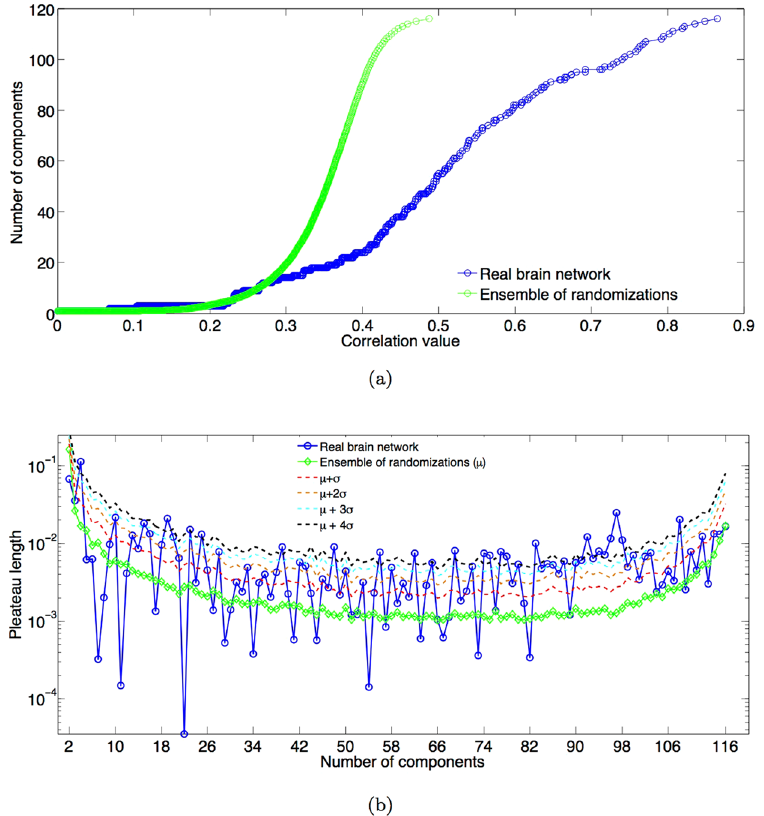
Figure 2. Percolation analysis. ( a ) Distribution of the number of network components versus the threshold applied to the correlation matrix. ( b ) Distribution of plateaux length observed in Fig. 1(a) and computed as the increment of correlation value between two newborn components. All figures show the percolation curves for the real case (blue) and the ensemble of its randomizations (green). Moreover figure ( b ) reports upper confidence intervals: mean plus respectively, one (red), two (orange), three (light blue) and four (bleak) standard